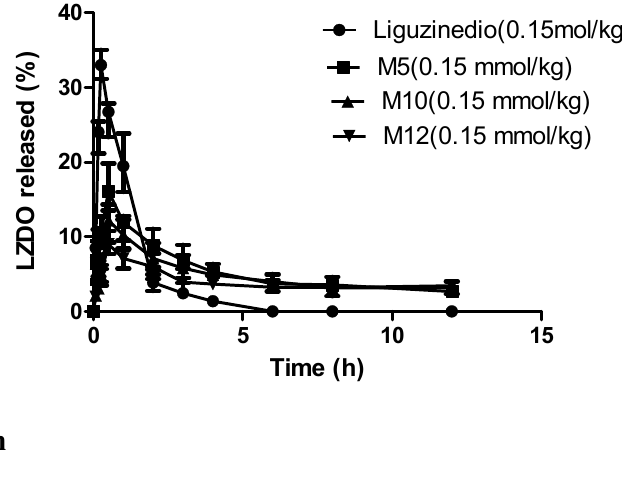
Figure 2. The plasma concentration versus time curves of LZDO after oral dosing of free LZDO , M5 , M10 and M12 at equimolar doses of 0.15